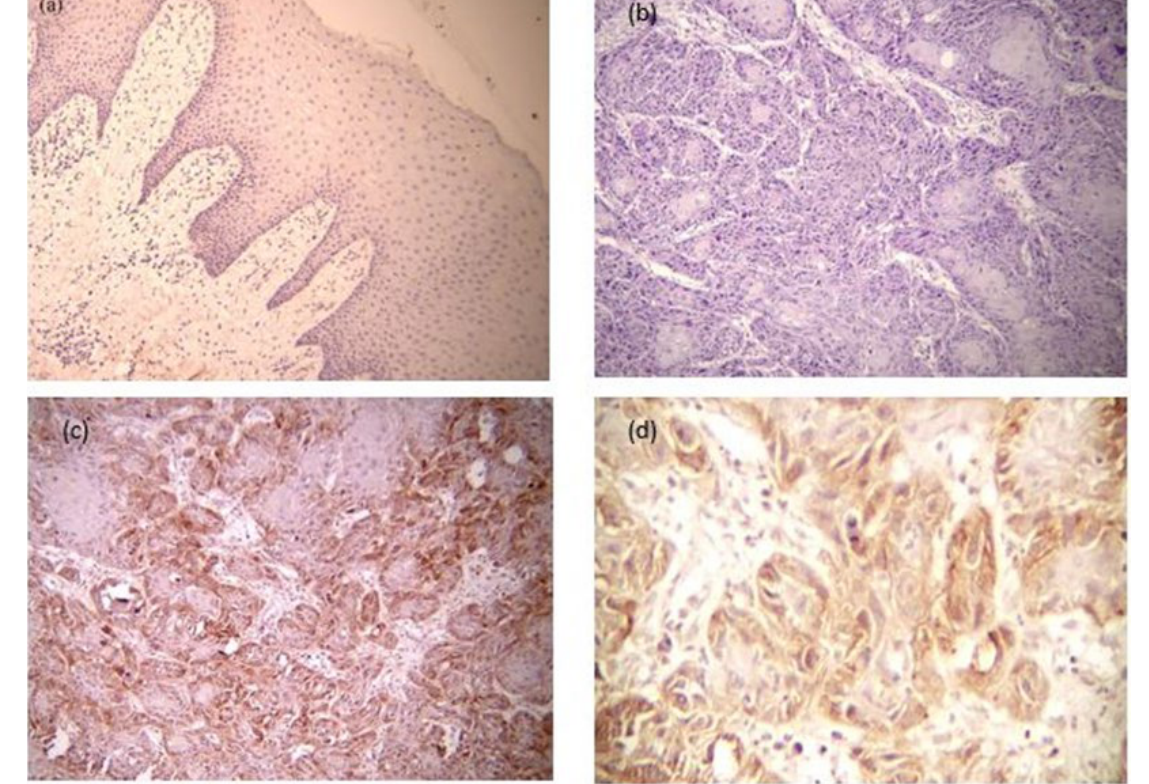
Fig 2. (a) Negative expression of N-cadherin in normal oral epithelium (×100). (b) H & E section of moderately differentiated OSCC (×100). (C) High expression of N-cadherin in OSCC in same H&E microscopic field (×100). (d) High expression of N-cadherin in OSCC (×400). Table 3. Expression of E-Cadherin and N-cadherin in different histopathological grades of OSCC